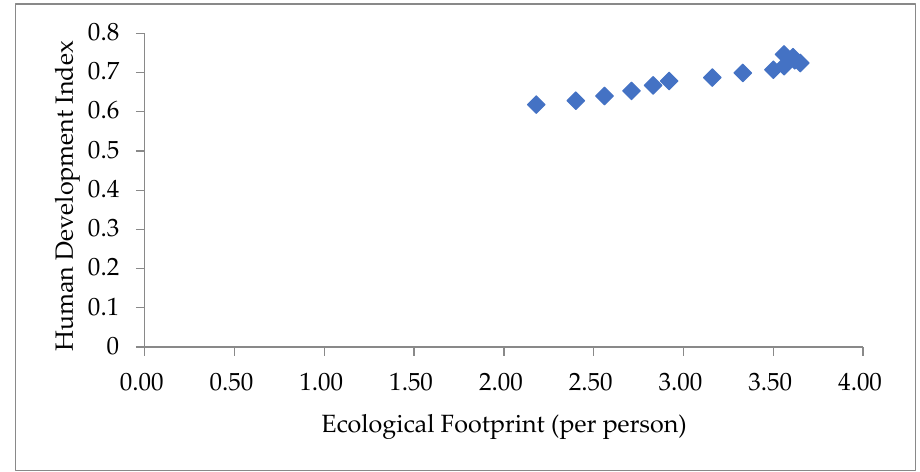
Figure 1. EF and HDI data of China from 2003 – 2016.